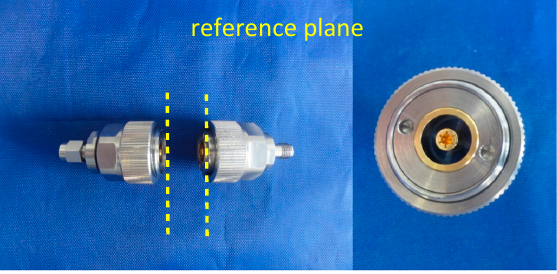
Figure 5. Sexless coaxial connectors (e.g., APC-7 series) with planes highlighted by dashed yellow lines.